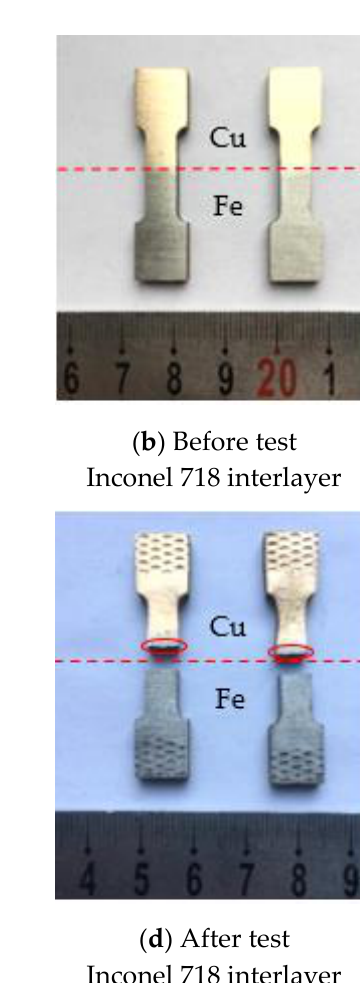
Figure 9. The morphology of the tensile samples without interlayer ( a , c ) and with Inconel 718 interlayer ( b , d ) before and after testing. Note: the thickness of the Inconel 718 interlayer was so small (approximately 0.7 mm) that the Inconel 718 interlayer is not clearly demonstrated in the above figure.